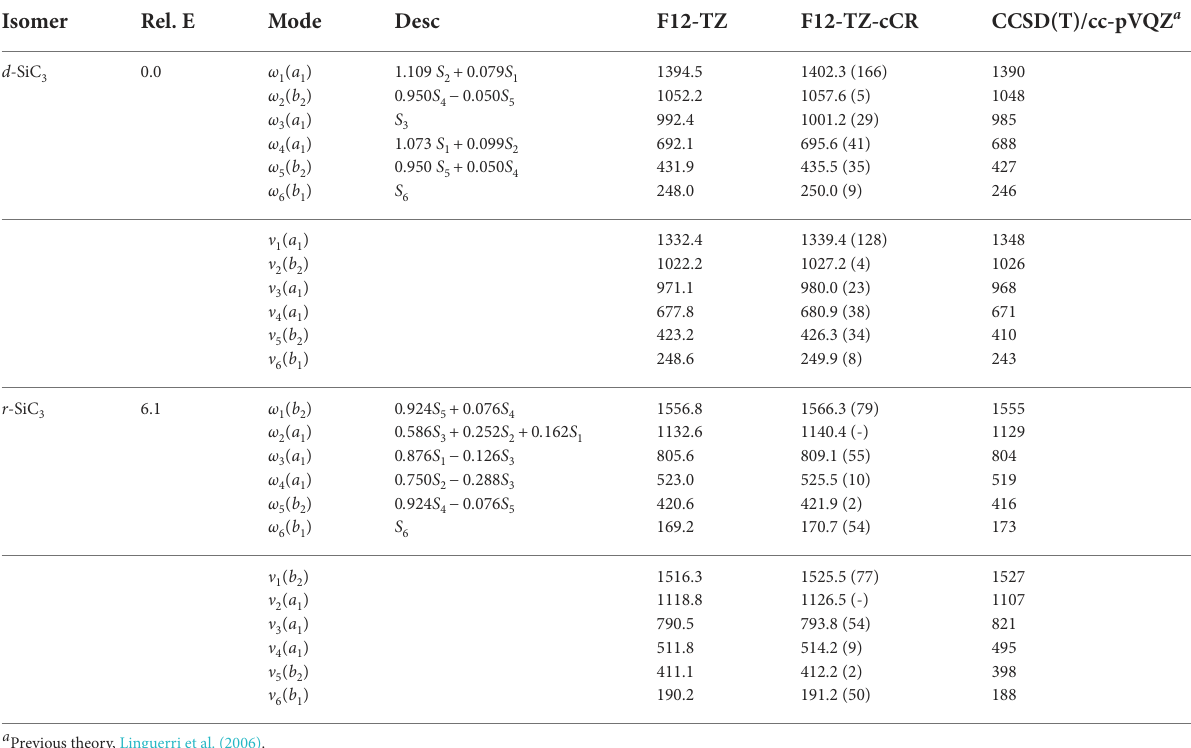
TABLE 4 Harmonic ( ω ) andFundamental ( ν ) VibrationalFrequencies(incm −1 )withIntensities(inkm mol −1 ,inParentheses)andRelativeEnergies(in kcal mol −1 )forSiC 3 Isomers.Modedescriptions(Desc.)refertotheSICsinEqns.1-24. Isomer Rel. E Mode Desc F12-TZ d -SiC 3